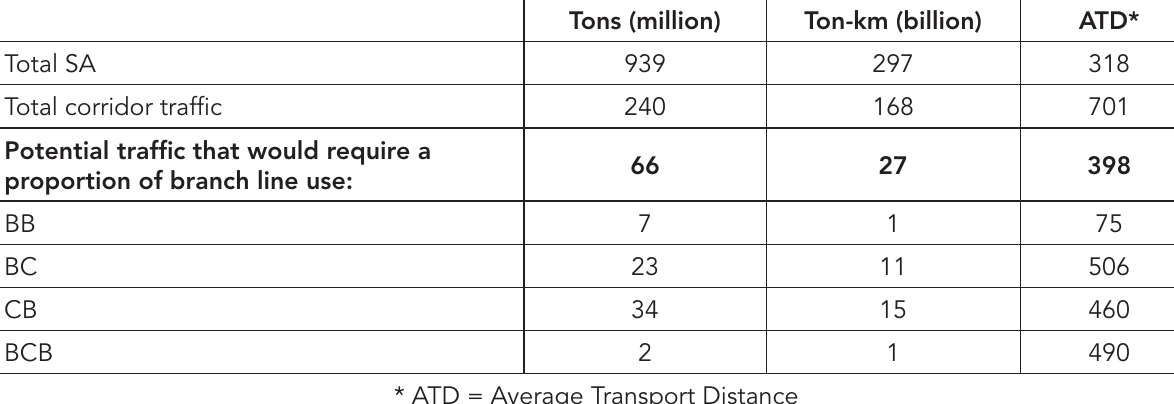
Table II: Relationship between total traffic and potential